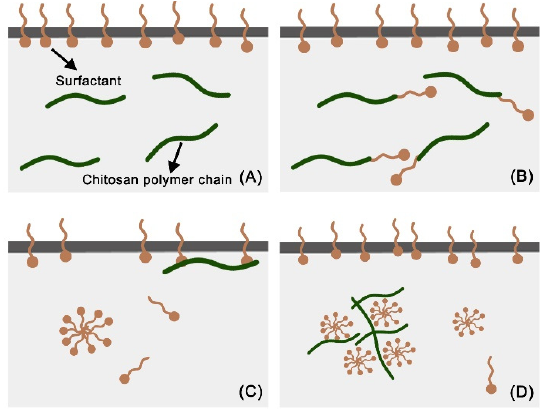
Figure 2. Interaction between chitosan solution and surfactant: ( A ) Surfactant at low concentra ‐ tion, ( B ) Dispersion of the chitosan–surfactant mixture, ( C ) Free micelles formation, ( D ) Hydro ‐ philic chains of chitosan and enzymes solubilized on the micellar surface